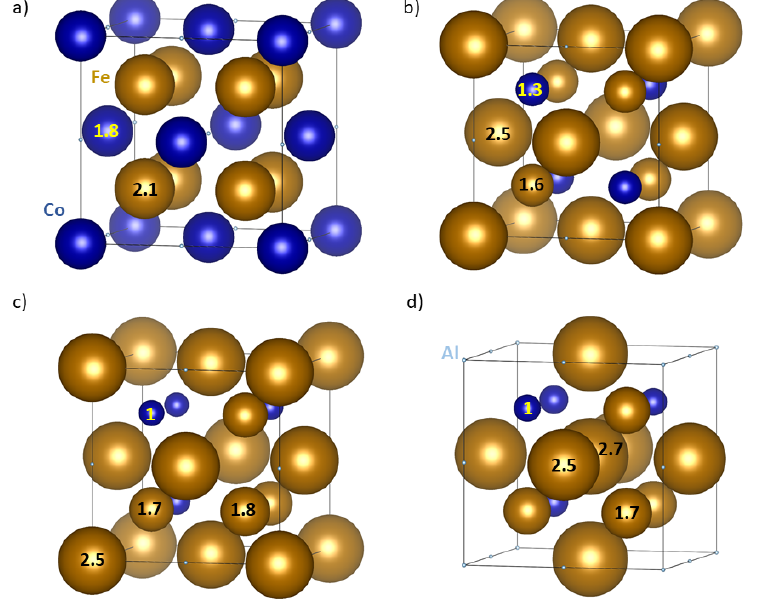
Figure 3. Schematic visualizations of local magnetic moments of atoms in the four studied Fe 2 AlCo polymorphs in the case of ( a ) the full-Heusler-structure variant, ( b ) inverse-Heusler polymorph, ( c ) specific distribution of Co (and Fe atoms) regarding the atoms in the 2NN shell (see the text), and ( d ) special arrangement of atoms of all three chemical species. Magnetic moments of Al atoms are antiparallel to those of Fe and Co atoms but their magnitudes are so small, less than 0.05 µ B , so that they can be considered as non-magnetic and are not shown in this figure. The numbers within the spheres indicate rounded values of local magnetic